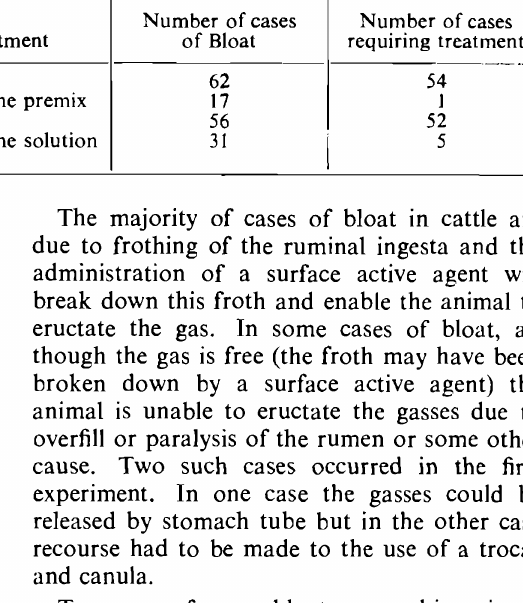
TABLE 2.-THE HFECT OF THE DAILY ADMINISTRATION OF A POLOXALENE PREMIX AND SOLUTION ON THE INCIDENCE OV BLOAT IN CATTLE ON A HlGH CONCENTRATE